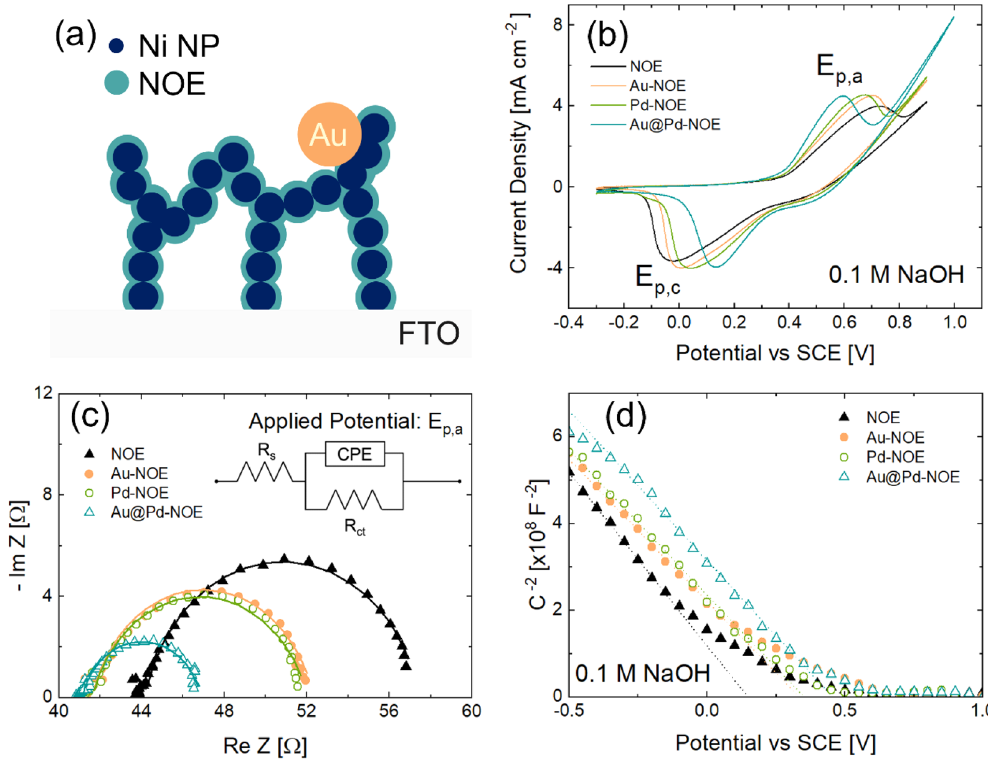
Figure 3. ( a ) Scheme of a cross section of decorated NOE. Electrochemical characterization of bare and decorated electrodes: ( b ) cyclic voltammograms, ( c ) Nyquist plots from EIS analyses, ( d ) Mott–Schottky plots. The bimetallic NP decoration induces a larger variation in comparison to the monometallic NP